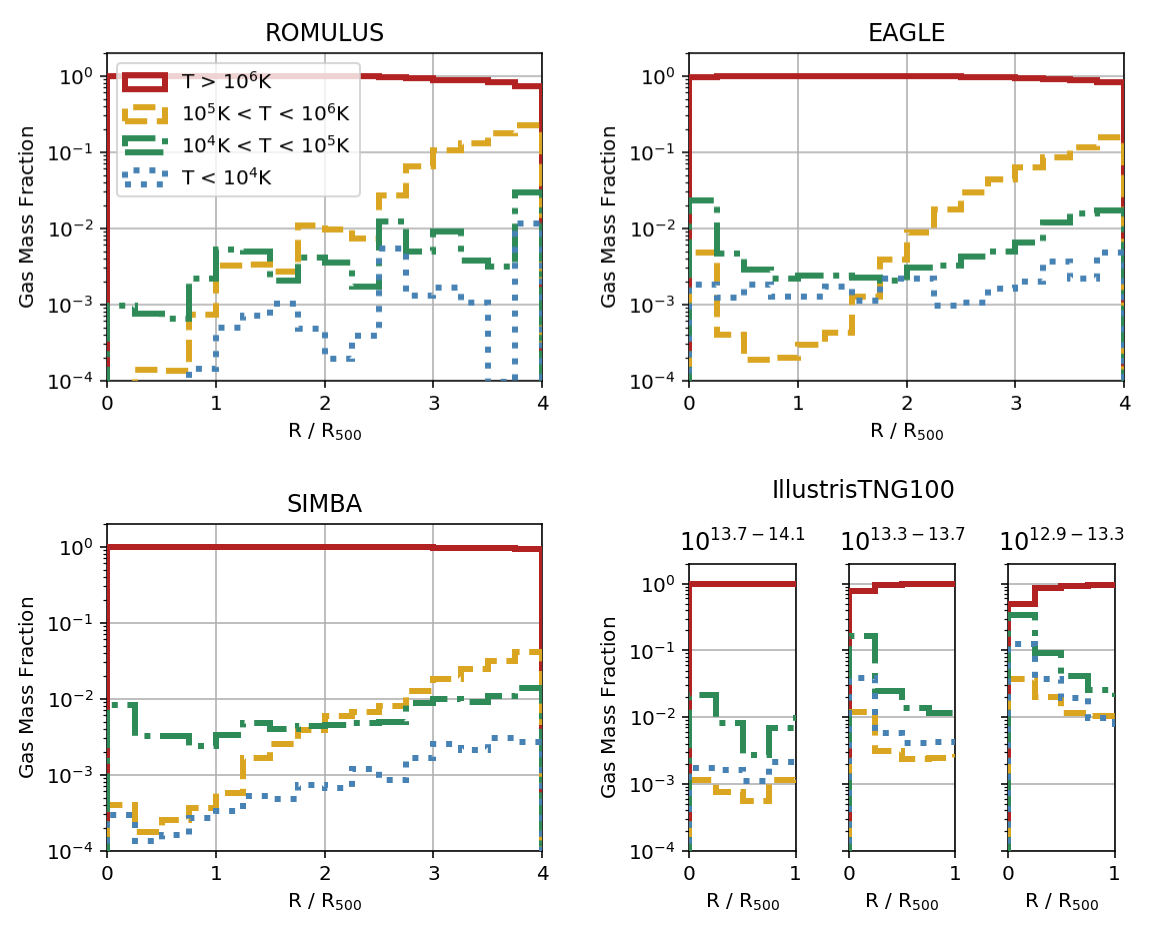
Figure 12. The total mass fraction of hot ( T ( T 10 4 K ) gas as a function of distance from the group center at z = 0 for halos at M 500 ≤ (ROMULUSC in this case), EAGLE ( N = 7 groups), SIMBA ( N = 39), and the inner regions of TNG100 for this bin (left subpanel, N = 13) and two lower mass halo bins (middle, M 500 = 10 13.3 − 13.7 M N = 105). Although hot gas dominates the mass fraction within 4 R 500 of the BGG in all cases, cool gas never constitute less than 10 − 3 of the total gas mass within R 500